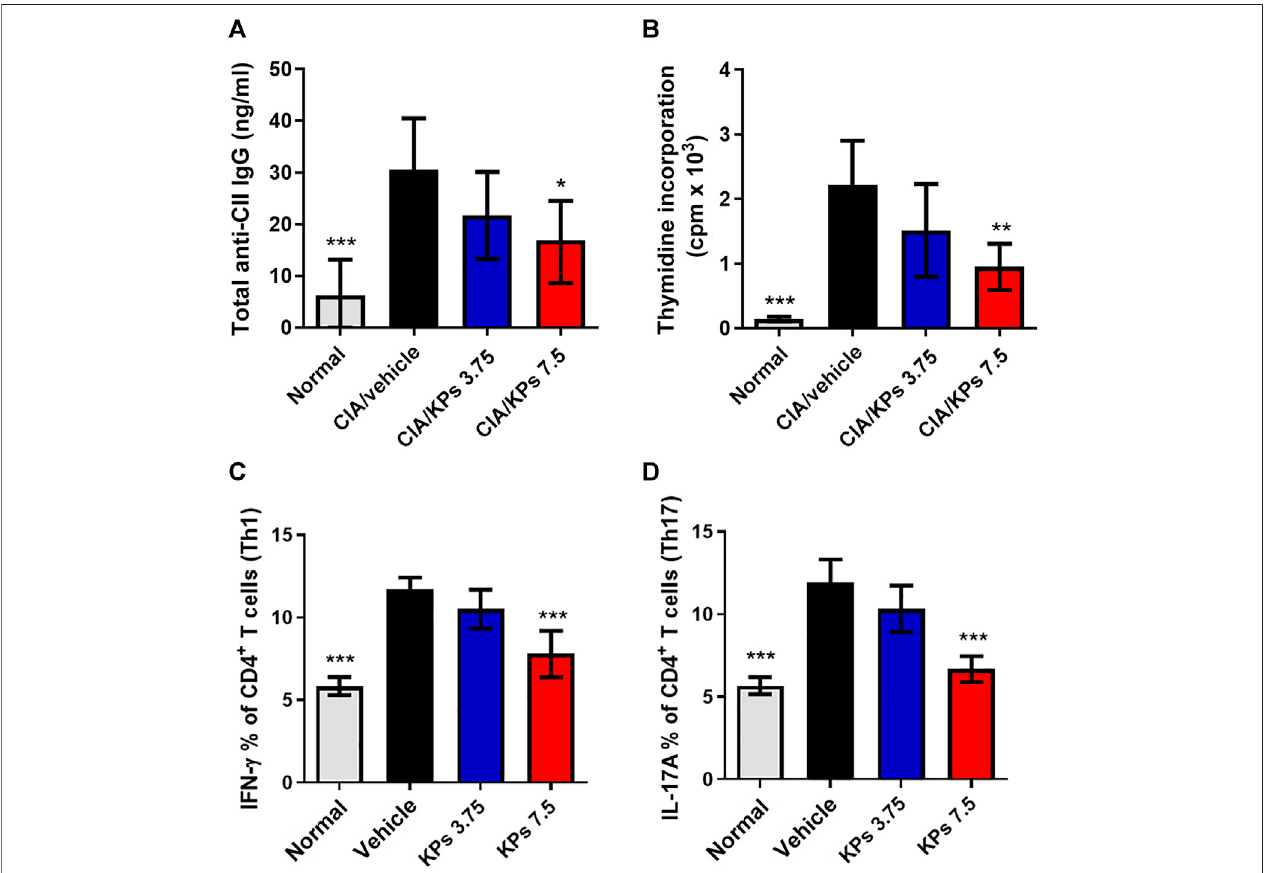
FIGURE 5 | Effect of KPs on CII-speci fi c immune responses in serum and the CD4 + T cell subset pro fi les in the spleens of CIA mice. (A) Sera were collected by orbitalsinusvenipunctureatday42afterprimaryimmunizationtoestimateanti-typeIIcollagen(IgG)antibodylevelsbyELISA. (B) Splenocyteswereharvestedatday42. Cultures were pulsed with 3 H-thymidine (1 μ Ci/well) and the incorporation of radioactivity was quanti fi ed in counts per minute (cpm) by liquid scintillation counting after 18 h of incubation. Intracellular fl ow cytometry analysis of cells collected from the spleens of the mice in different groups on day 42 after immunization. Flow cytometry analysis of Th1 and Th17 cells. The cells were gated on the CD4 + population. Bar graph of the quanti fi cation of CD4 + T cell subsets, Th1 (C) and Th17 (D) , plotted from three independent experiments. The data are expressed as the mean ± SEM (n (cid:1) 5). * p < 0.05; ** p < 0.01; *** p < 0.001 vs the CIA/vehicle control group, as determined by one-way ANOVA with Dunnett ’ s